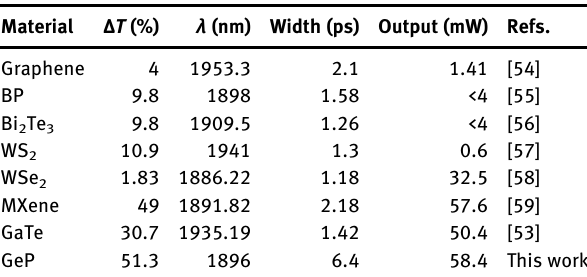
Table  : Summary of the pulse performance of ultrafast fi ber lasers with different  D material SAs at  µm.